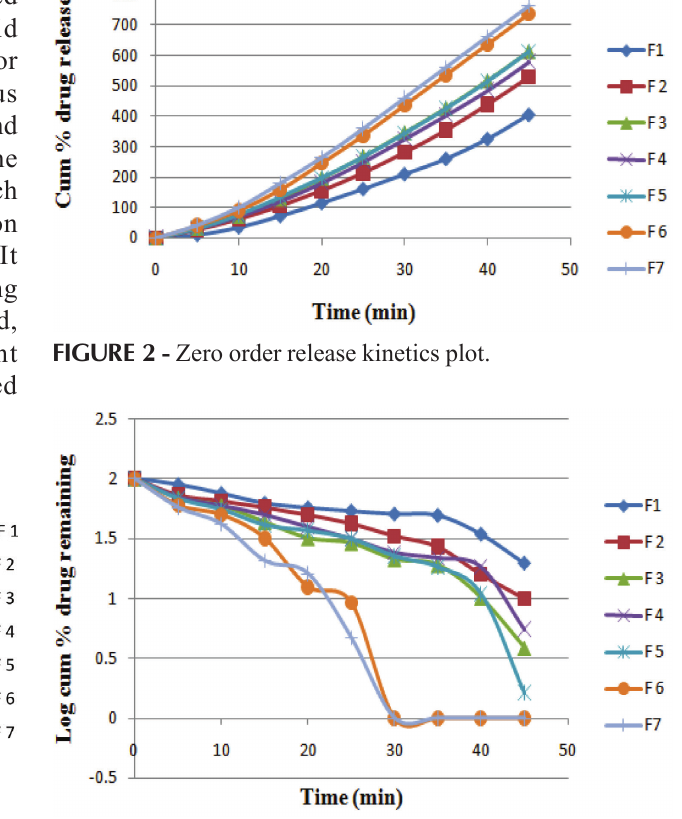
FIGURE 3 - First order release kinetics plot.